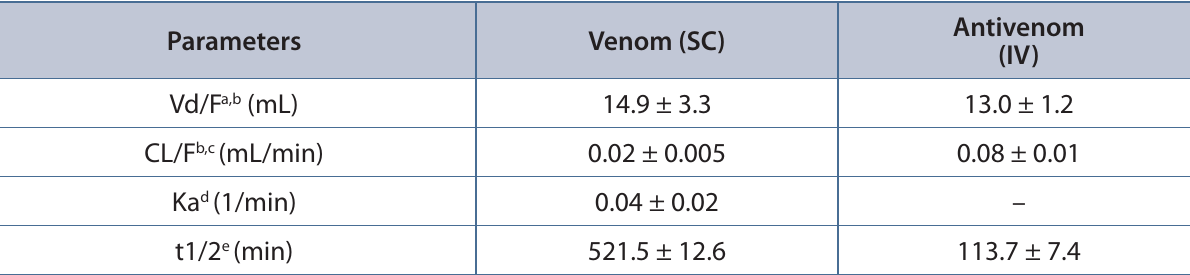
Table 2. Pharmacokinetic parameters of 125 I-radiolabeled H. lepturus venom and its multivalent antivenom. Ten microgram of H. lepturus venom and 0.2 mL of antivenom were administered via subcutaneous (SC) and intravenous (IV),